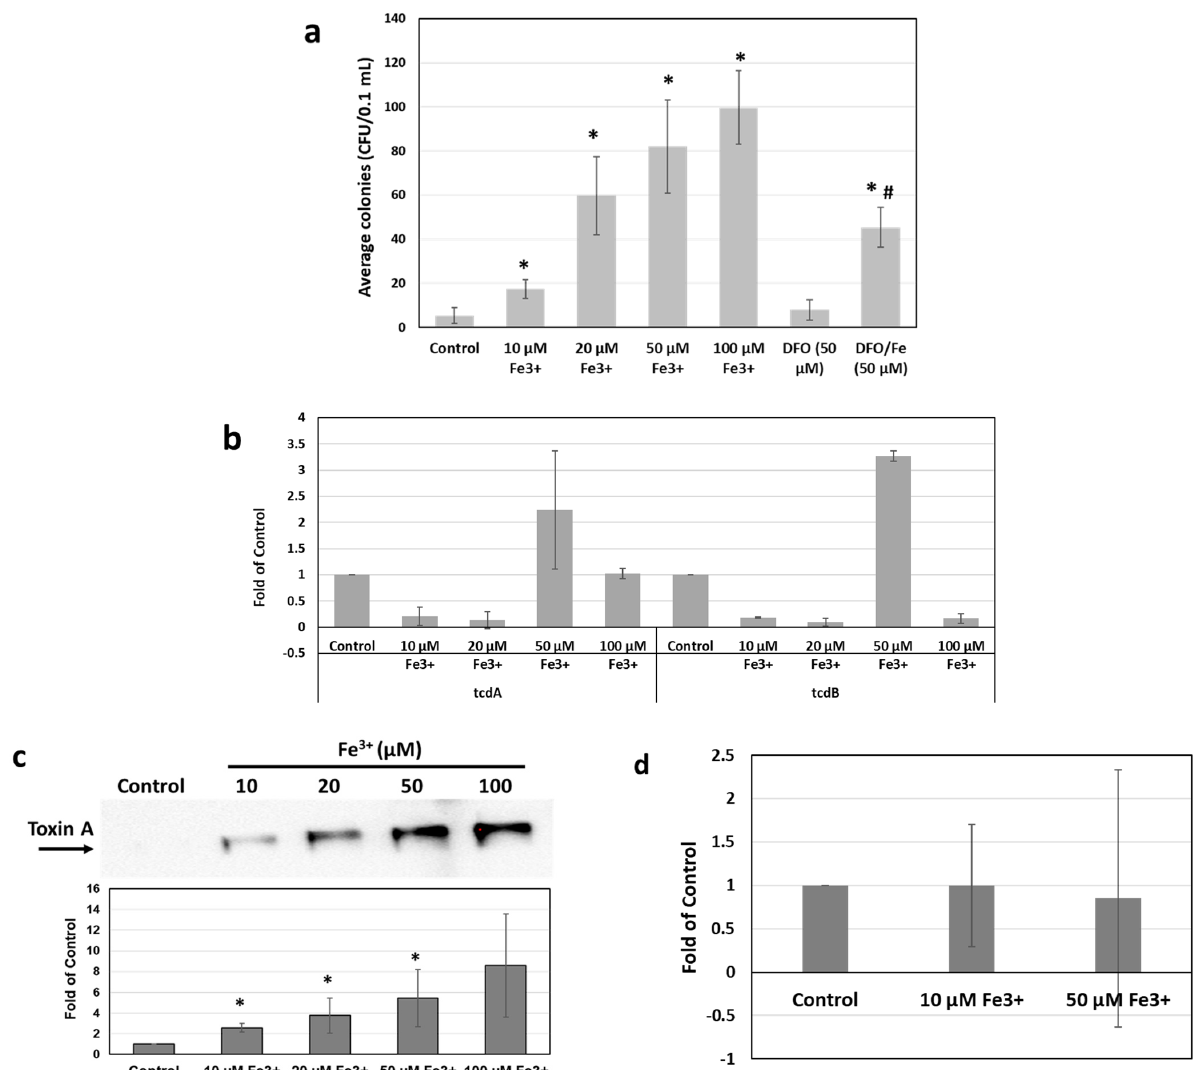
Figure 1. Effects of iron on C. difficile colony formation and production of toxins: ( a ) the increase in colony formation units following Fe 3+ treatments was suppressed by iron chelator DFO co-treatment in C. difficile strain 9689. The results are presented as the average of colonies formed from three plates. *, p < 0.05 compared to vehicle control; #, p < 0.05 compared to 50 µ M Fe 3+ ; ( b , c ) C. difficile toxins expressions were increased by iron exposure. After 16 h treatments, total RNA or concentrated bacterial supernatants were collected for qRT–PCR ( b ) and Western Blot ( c ) analyses. The mRNA expression levels of tcdA and tcdB were normalized by GAPDH expression and standardized by vehicle control. After treatments, equal volumes of clear concentrated supernatants were subjected to SDS–PAGE Western Blotting to determine the toxin A levels. *, p < 0.05 compared to vehicle control; ( d ) the expression levels of toxin A after iron treatment detected by Western Blot were further adjusted by CFU values in the 9689 strain. The results are presented as the average of three experiments.